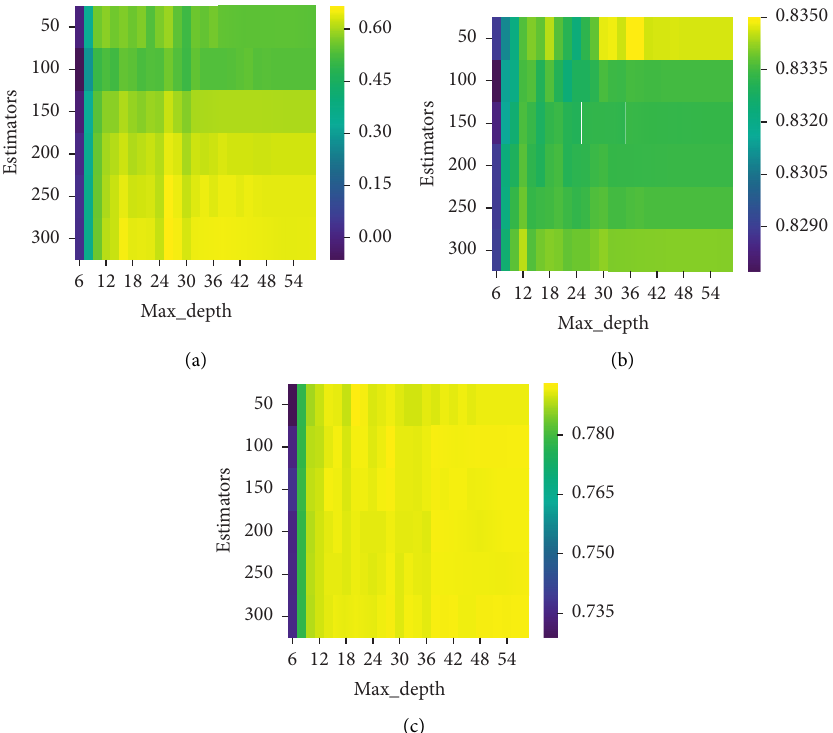
Figure 14: Parameter tuning for regression models. Estimators are [50 : 300, step 50] and Max_Depth are [6 : 58, step 2]. (a) G Speed Rate, (b) V Speed, and (c) Δ Course.